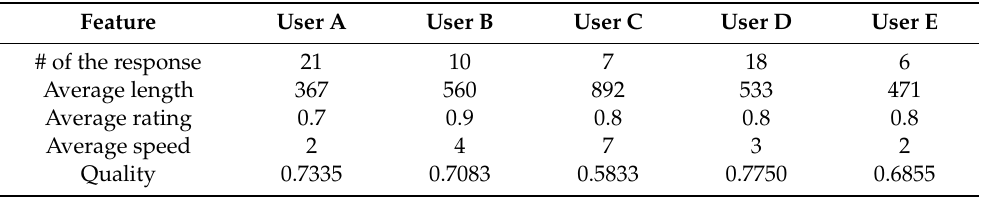
Table 1. Qualities of